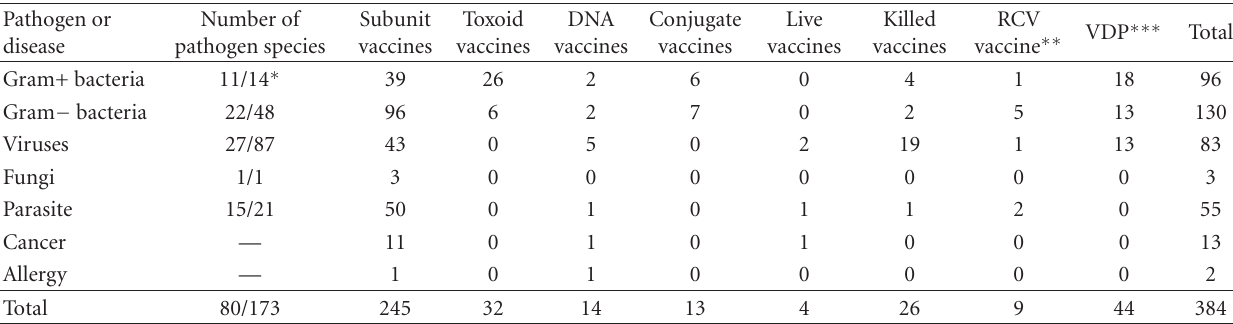
Table 5: Vaccines with adjuvants by vaccine-targeted pathogens or